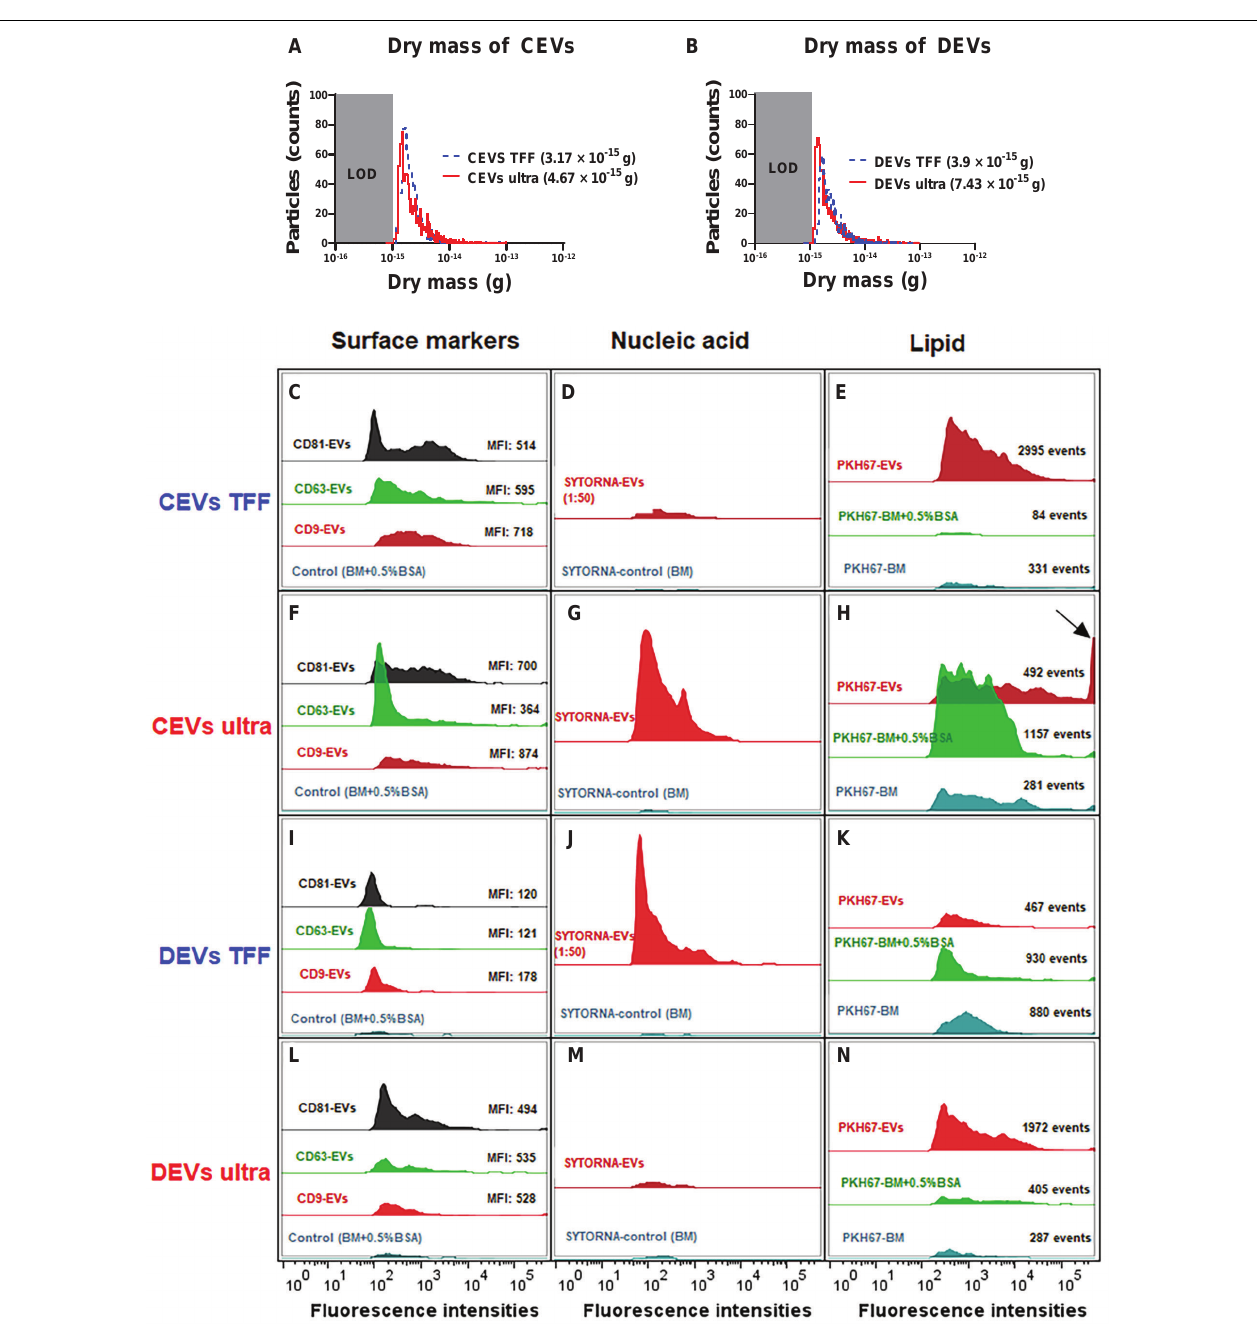
FIGURE 2 | The dry mass of different isolated EVs, and EV molecular composition was analyzed using nano-flow cytometry (nFCM). The dry mass of TFF and ultracentrifugation-isolated (A) CEVs and (B) DEVs. LOD, limit of detection. Representative histograms showing the presence of three surface markers CD9, CD63, and CD81 (C,F,I,L) , nucleic acid (D,G,J,M) , and lipid content (E,H,K,N) in CEVs and DEVs isolated using TFF and ultracentrifugation. The arrow indicates the saturated fluorescence peak. MFI, mean fluorescence intensity.